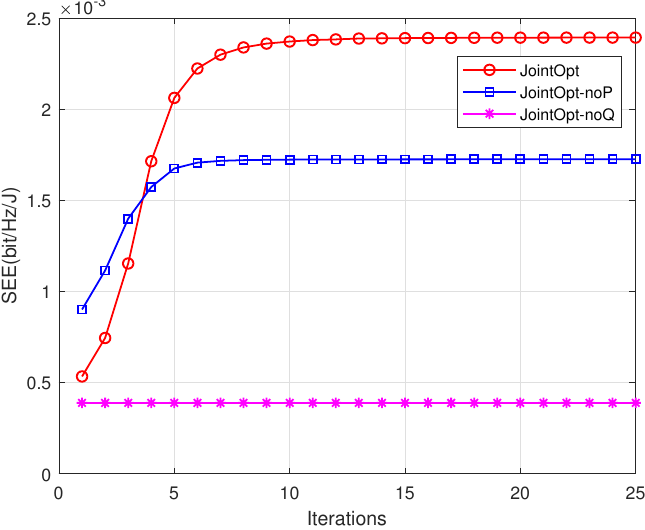
Figure 5. Convergence diagram of joint optimization